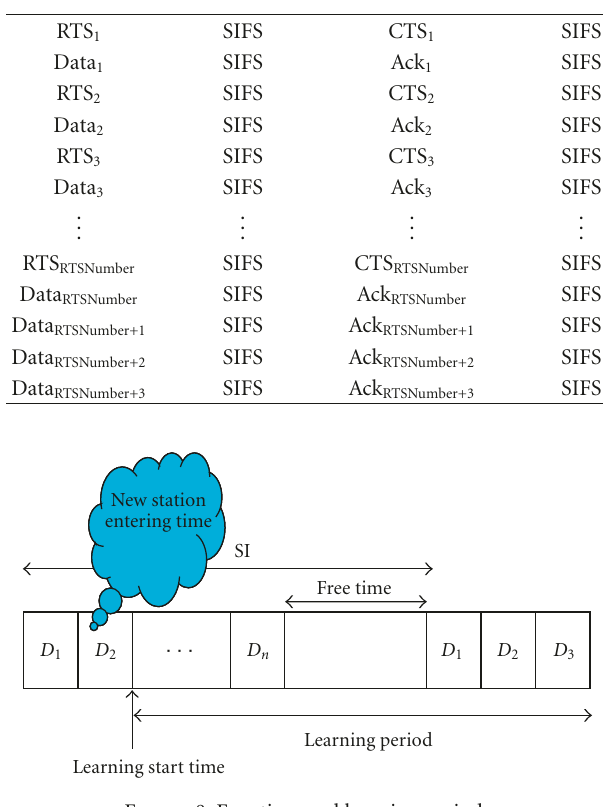
Figure 8: Free time and learning